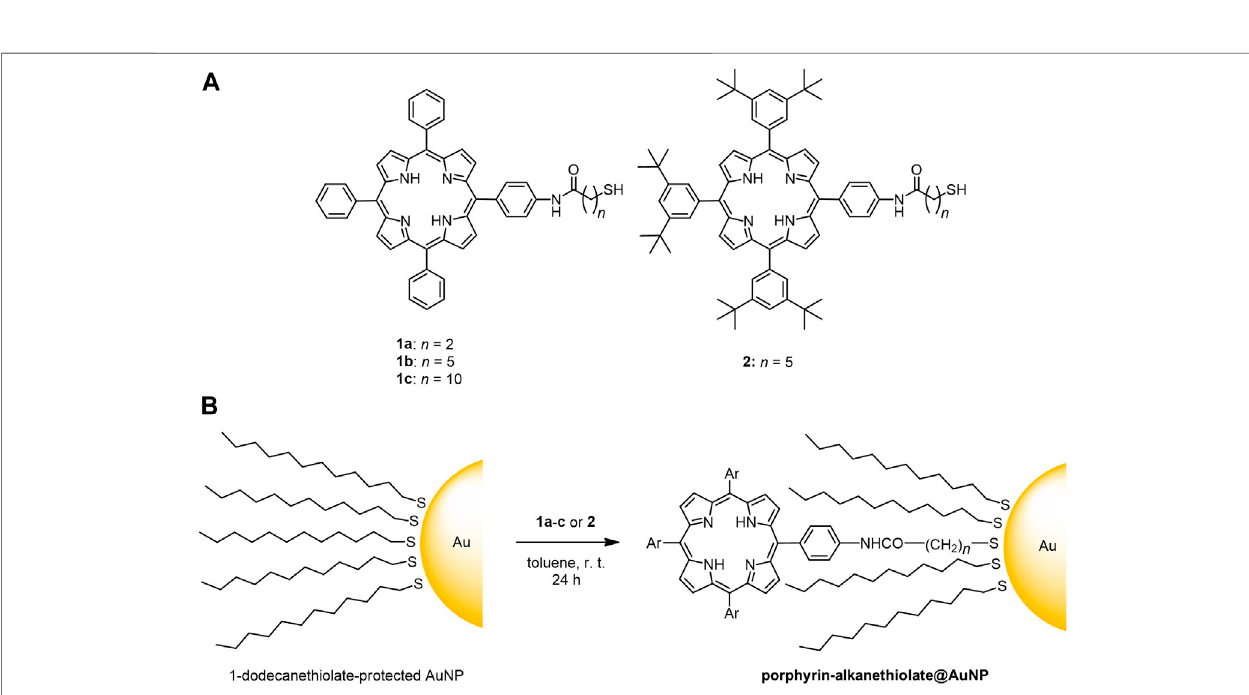
FIGURE 1 | UV-vis extinction spectra (in toluene) of (A) 1b@A and (B) 2@A prepared by post-synthetic modi fi cation of nanoparticle A with different initial concentrations of porphyrin – alkanethiols ( c 0 ). Insets represent the normalized absorption spectra of porphyrin